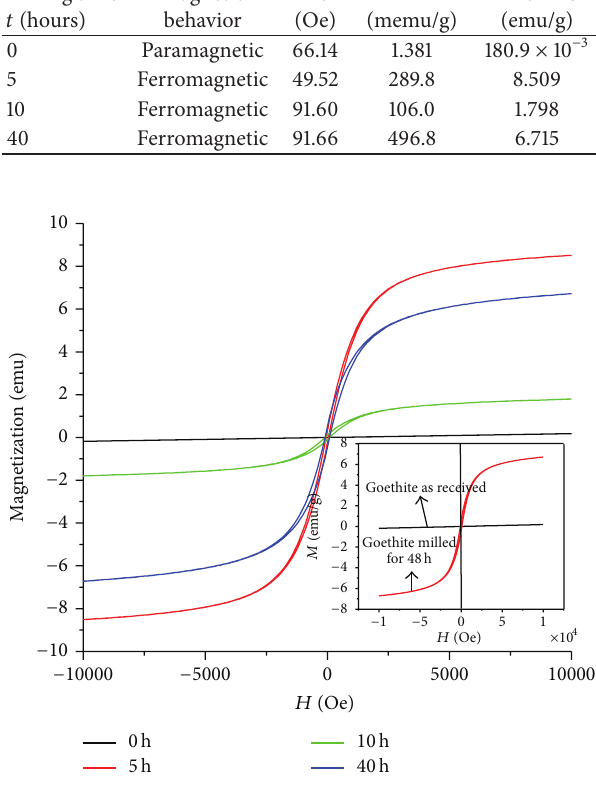
Figure 5: Magnetic hysteresis loop of the samples as received and milled for 40h. The inset shows comparison between the sample as received which is paramagnetic and the one milled for